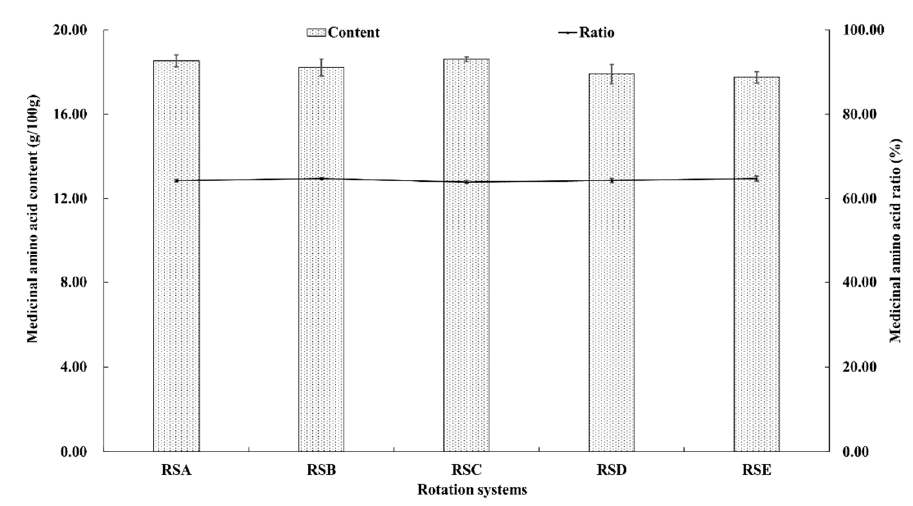
Figure 6. The total and proportional medicinal amino acid content of M. importuna under different rotation systems.